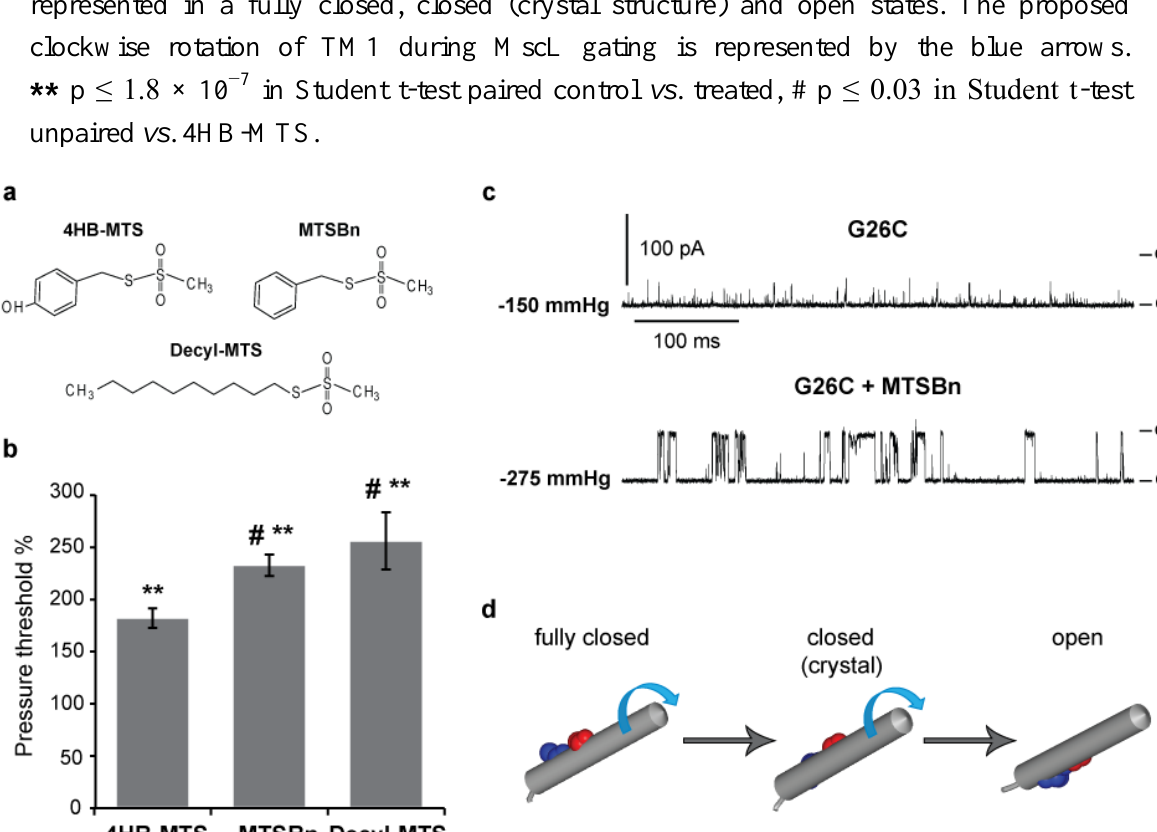
Figure 4. Effects of hydrophobic MTS modifications in G26C MscL gating. ( a ) Structures of the hydrophobic MTS reagents 4-HB-MTS, MTSBn and Decyl-MTS are shown. ( b ) A bar graph showing the pressure threshold changes of G26C MscL when treated with 50 µM 4-HB-MTS, 100 µM MTSBn or 10 µM Decyl-MTS. The changes in the pressure